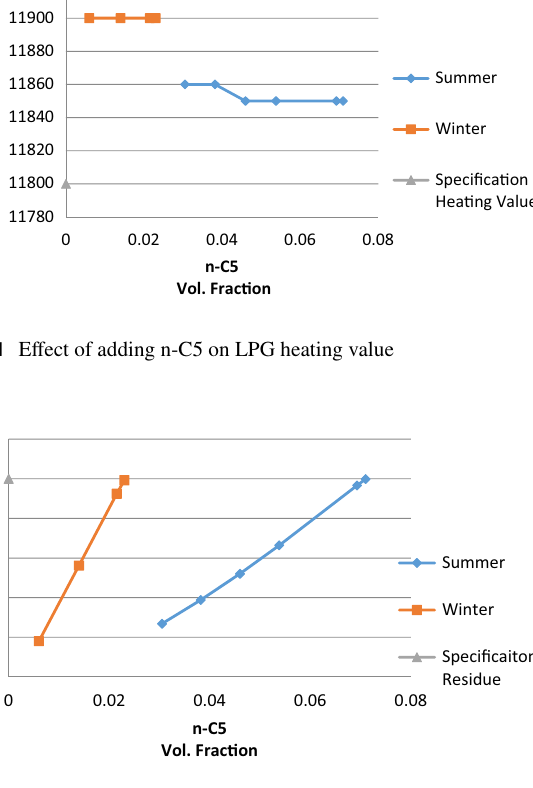
Fig. 22 Limitation of adding n-C5 to LPG